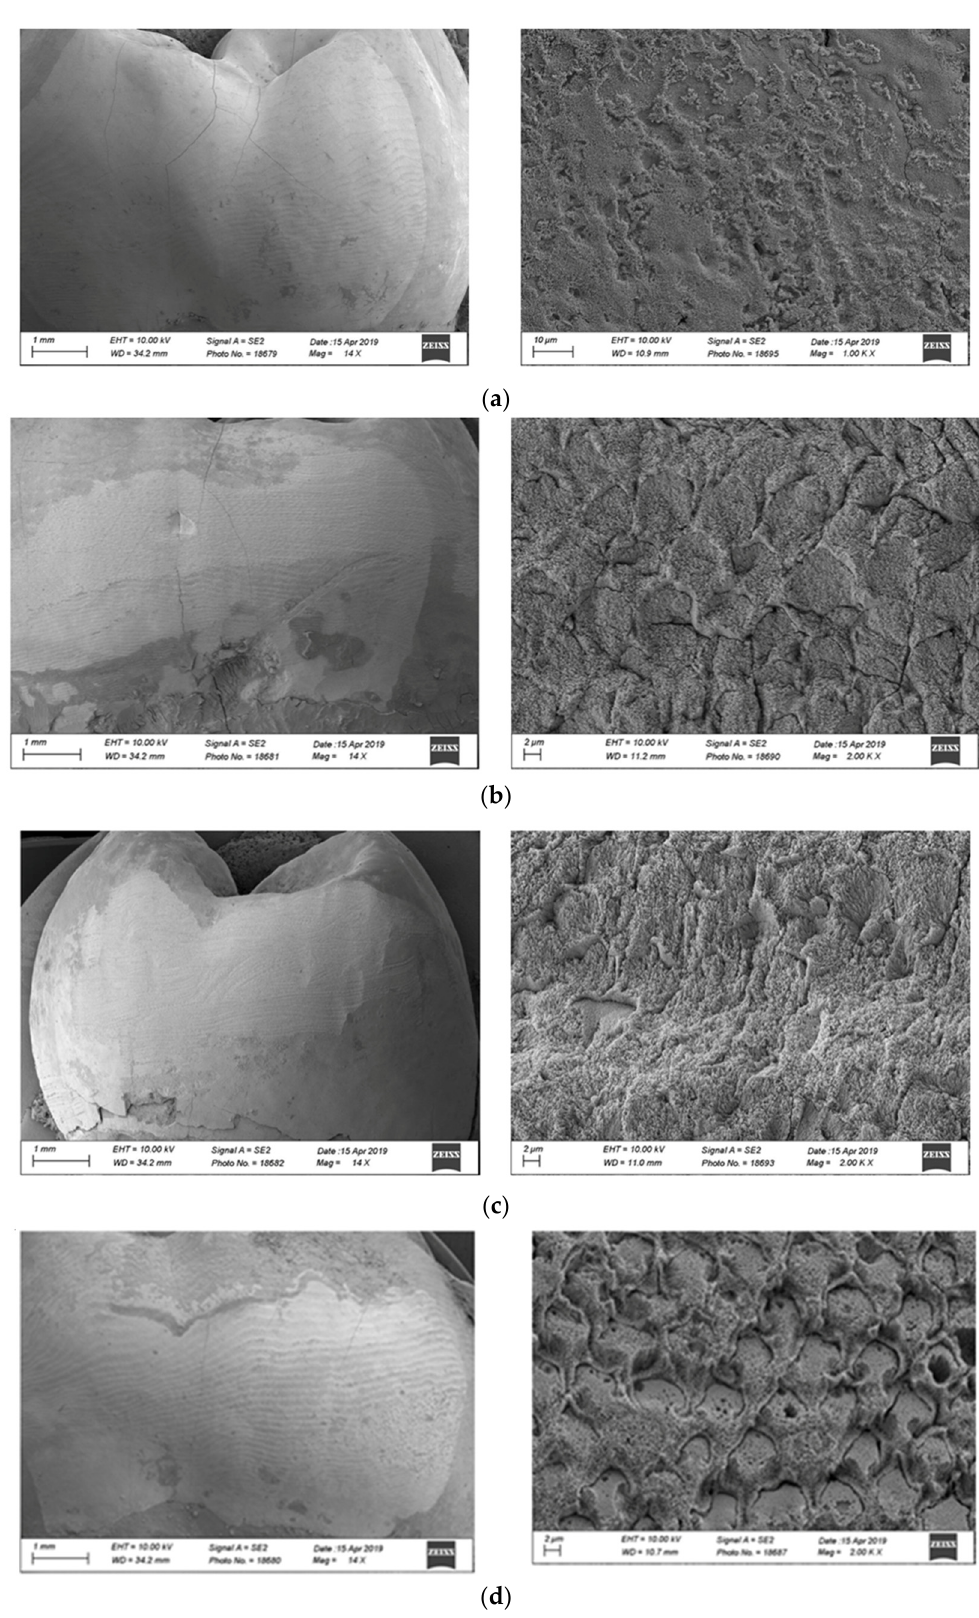
Figure 3. SEM images of different enamel surface treatments. ( a ) (Group U15) Enamel prisms are hardly detectable. ( b ) (Group U30) Enamel prisms are more visible. ( c ) (Group G15) Enamel prisms are more prominent. ( d ) (Group G30) Enamel prisms are very detectable, and bonding area appears to be larger.